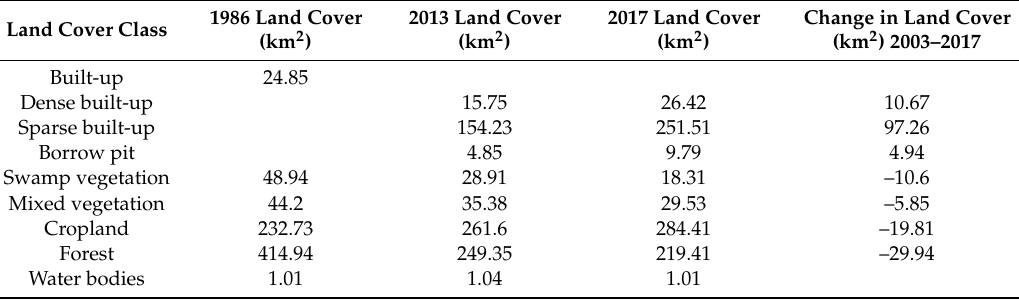
Table 3. Land cover use statistics of Uyo from 1986 to 2017.